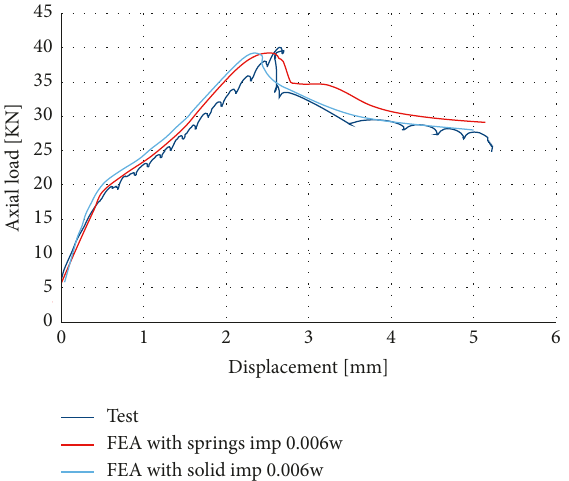
Figure 22: Experimental and numerical axial load-displacement curves of C90-0.9-300-A braced